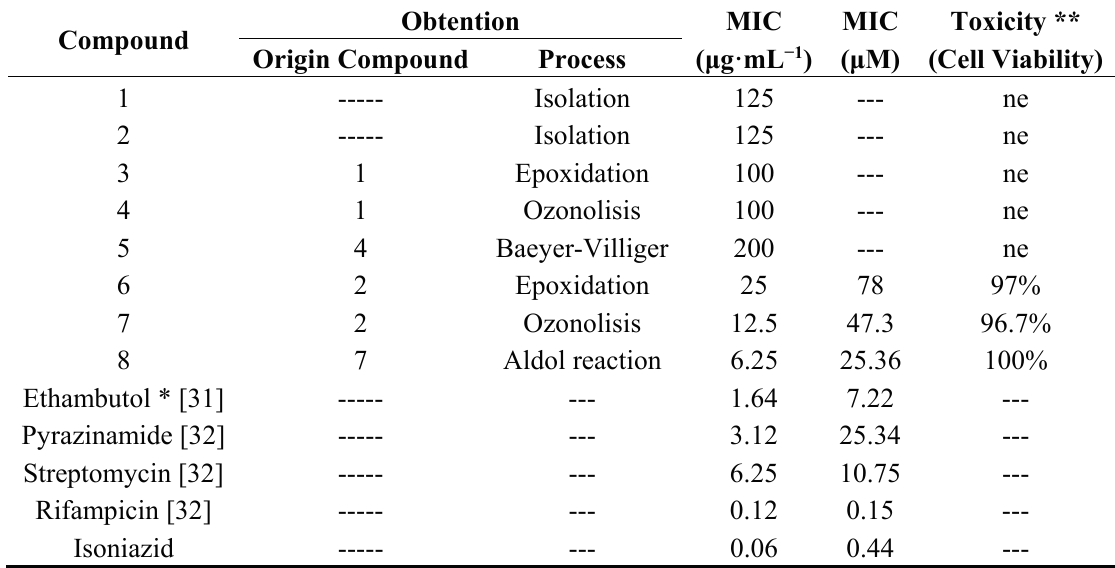
Table 2. Results obtained in the anti-tuberculosis potential and toxicity evaluation together with reference values for first line